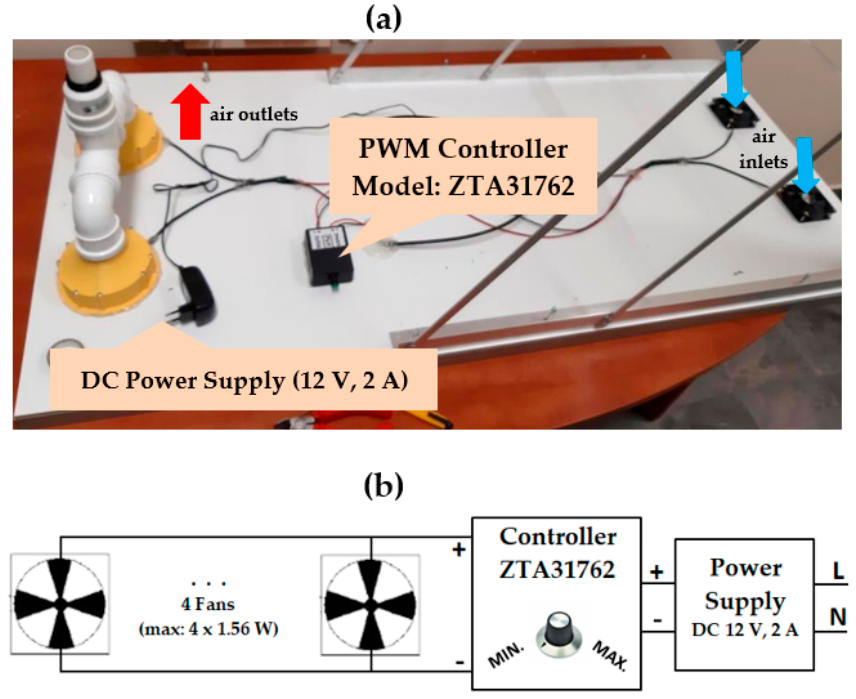
Figure 2. Construction of the cooling system for the modified PV module: ( a ) arrangement and installation of fans; ( b ) electric diagram of the power supply and fan speed controller.